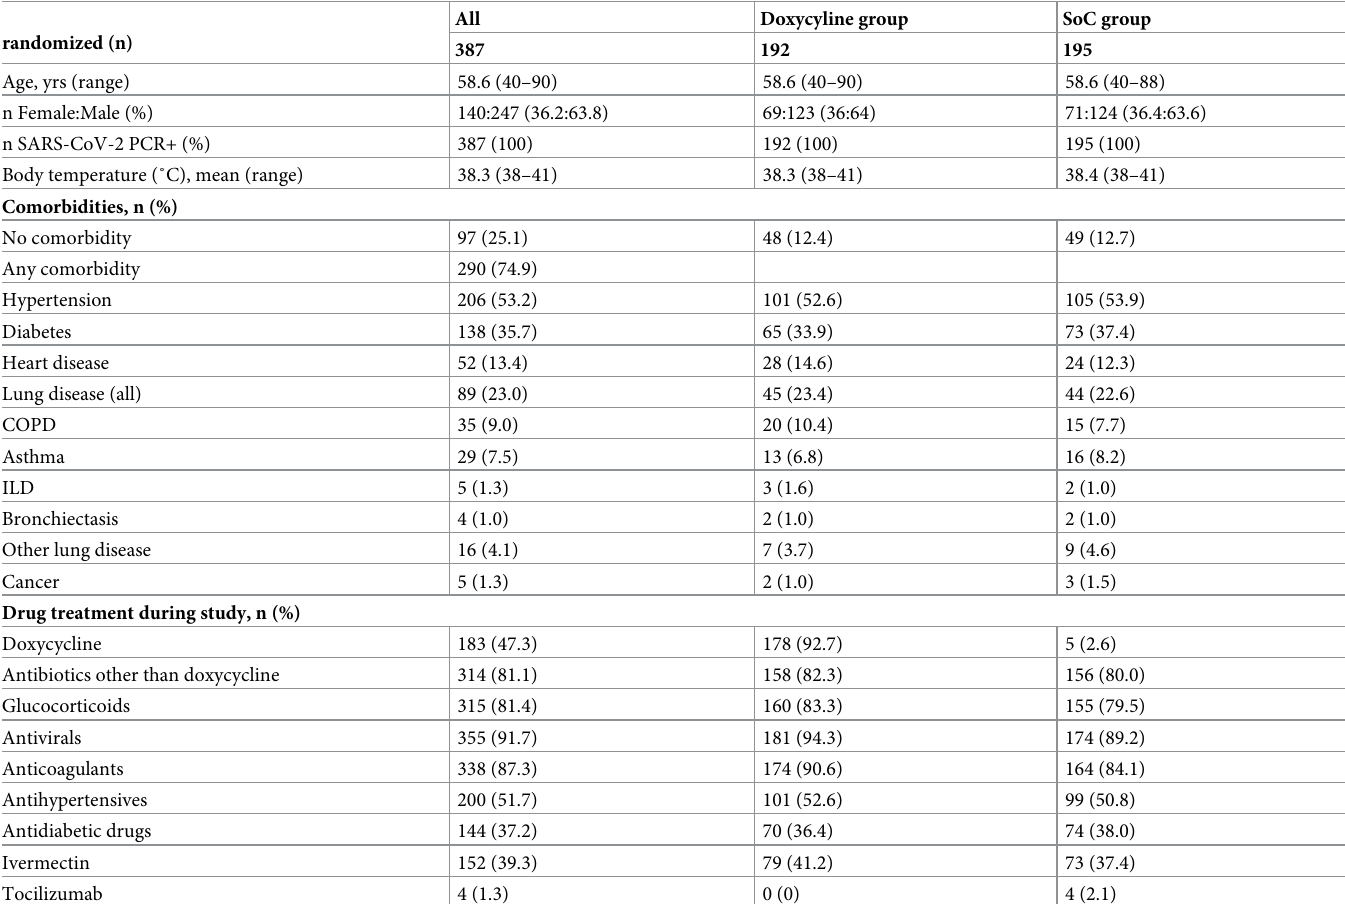
Table 1. Baseline characteristics and drug treatment during the